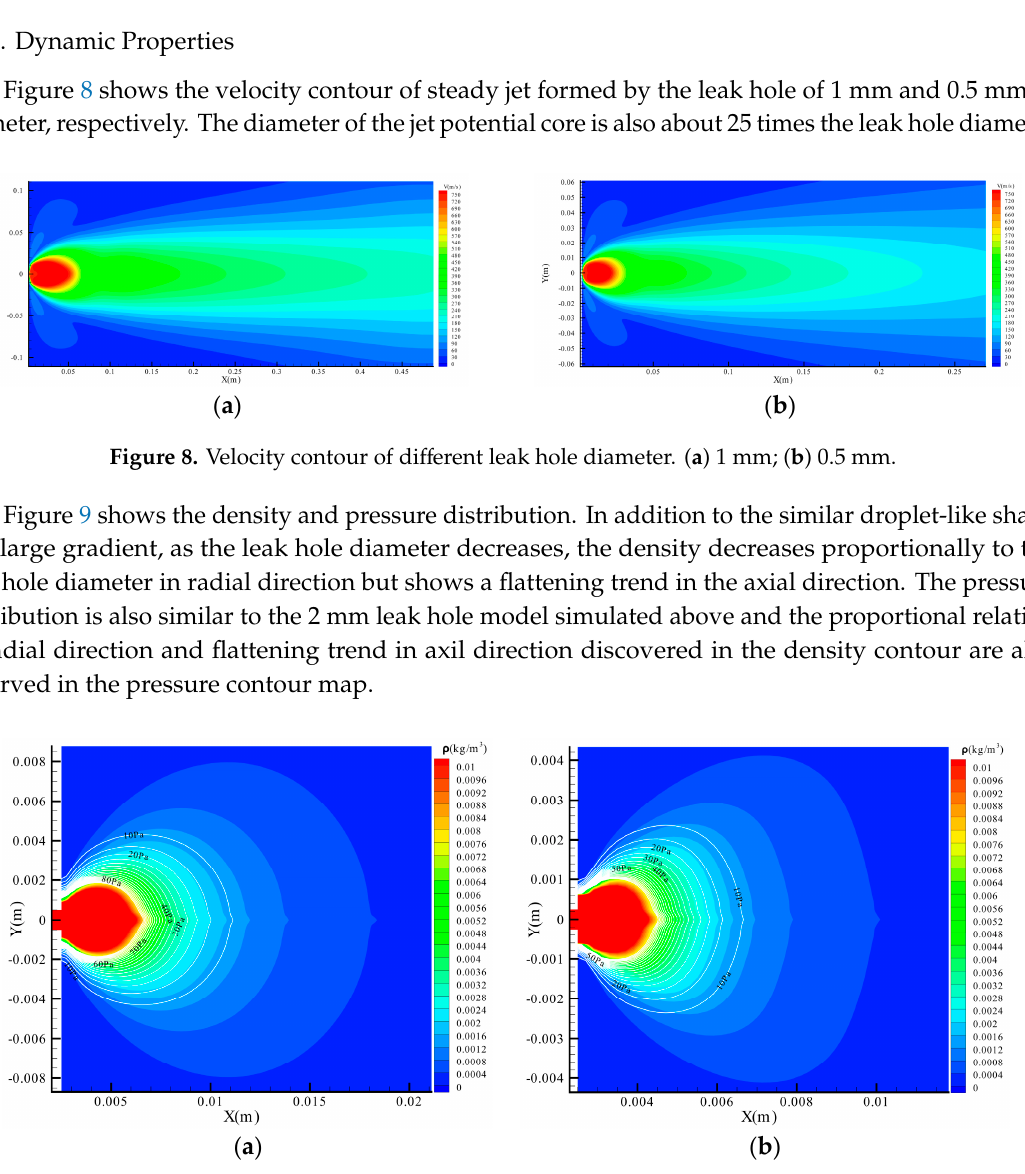
Figure 7. Pressure fluctuation contour of different external environment (The arrow marked in the figure represents the direction of fluctuation wave propagation.). ( a ) vacuum environment; ( b ) atmospheric environment.